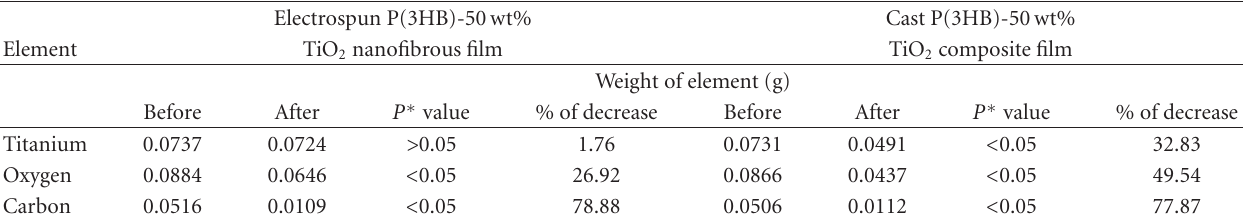
Table 1: Energy dispersive X-ray (EDX) analysis on electrospun P(3HB)-50wt% TiO 2 and cast P(3HB)-50wt% TiO 2 composite films after usage in ten repeated decolorization experiments.